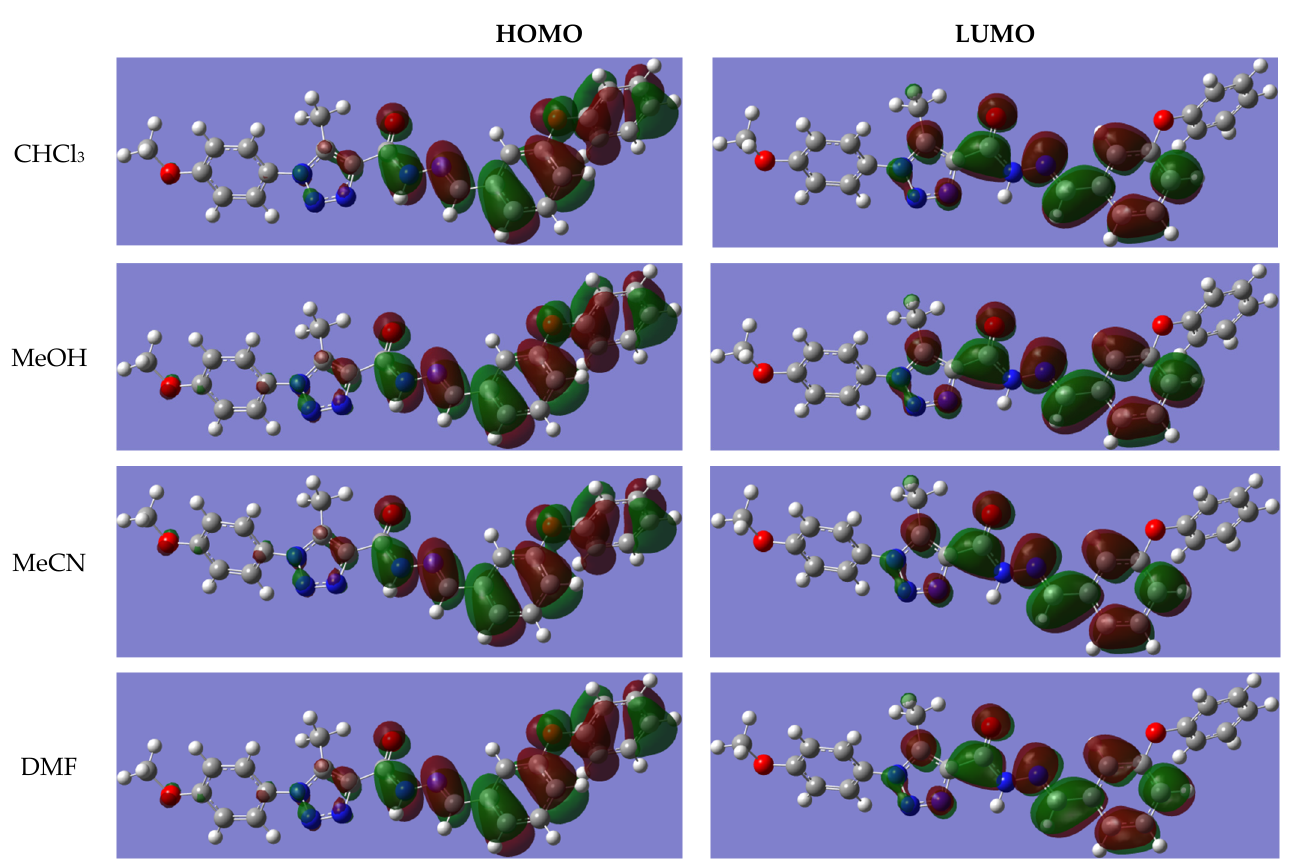
Figure 9. HOMO and LUMO simulations of 2 . Red and green colors indicate negative and positive charges, respectively, within 2 .